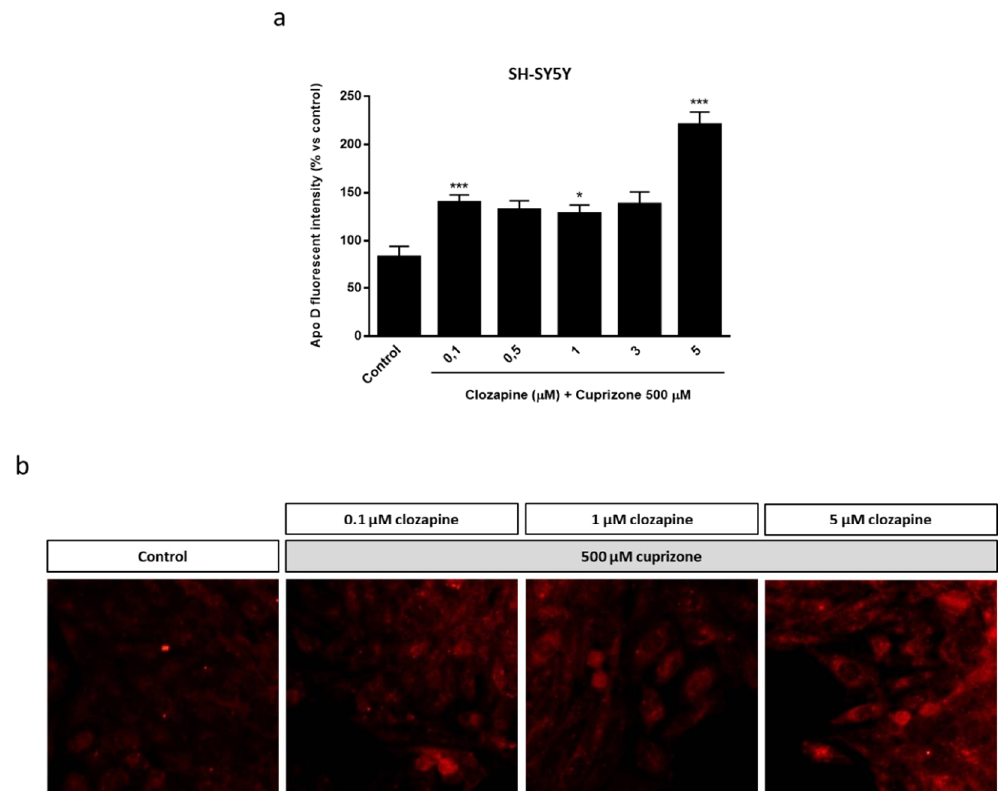
Figure 7. Densitometric quantification of Apo D immunocytochemical signal in SH-SY5Y cells after 24 h of treatment with increasing concentrations of CLO (0.1–5 µM) followed by 24 h with 500 µM of CPZ ( n = 6). Bars represent mean density per cell in a 40× field ± SEM (% versus control). Significant differences were analyzed by a one-way ANOVA followed by post-hoc Tukey’s test. * p < 0.05, *** p < 0.001 compared with control ( a ). Representative fluorescence microscopy images of Apo D expression in SH-SY5Y cells treated with increasing concentrations of CLO (0.1–5 µM) followed by 24 h with 500 µM of CPZ. 40× magnification ( b ).